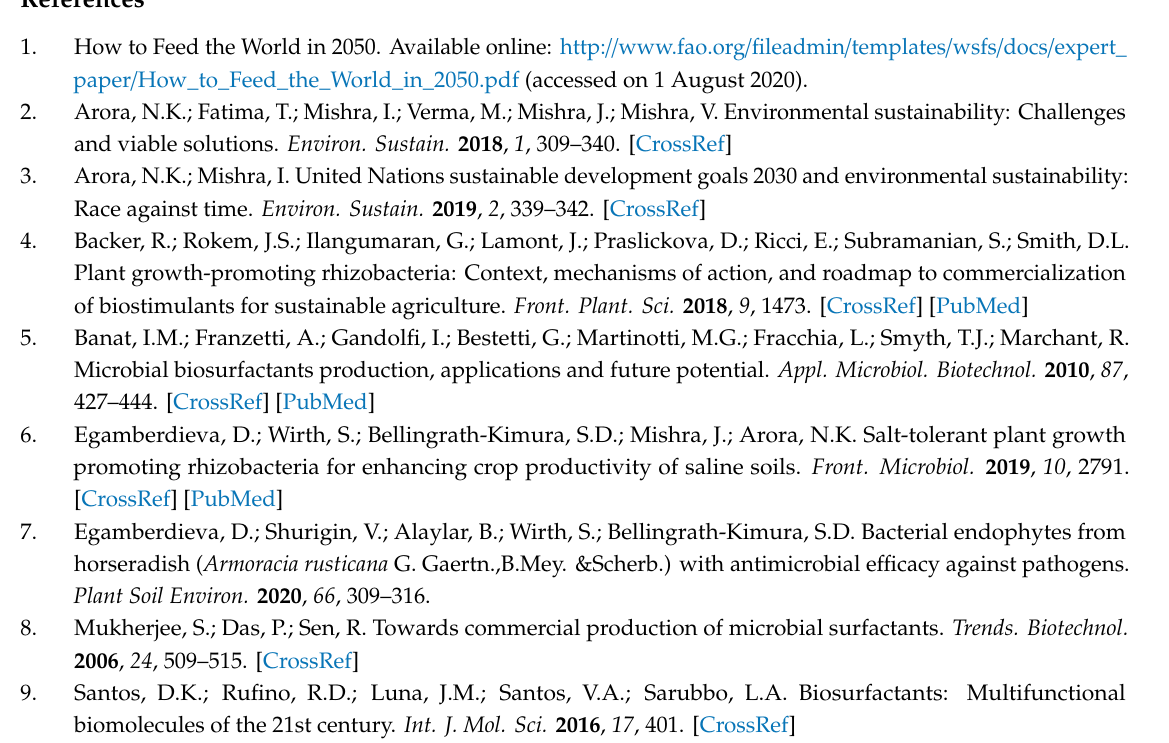
Figure S1: Phylogenetic tree of the isolate BSP9; Figure S2: Isolate BSP9 showing positive BAP test due to the presence of blue halo around culture well; Figure S3: showing TLC analysis of the crude biosurfactant produced by